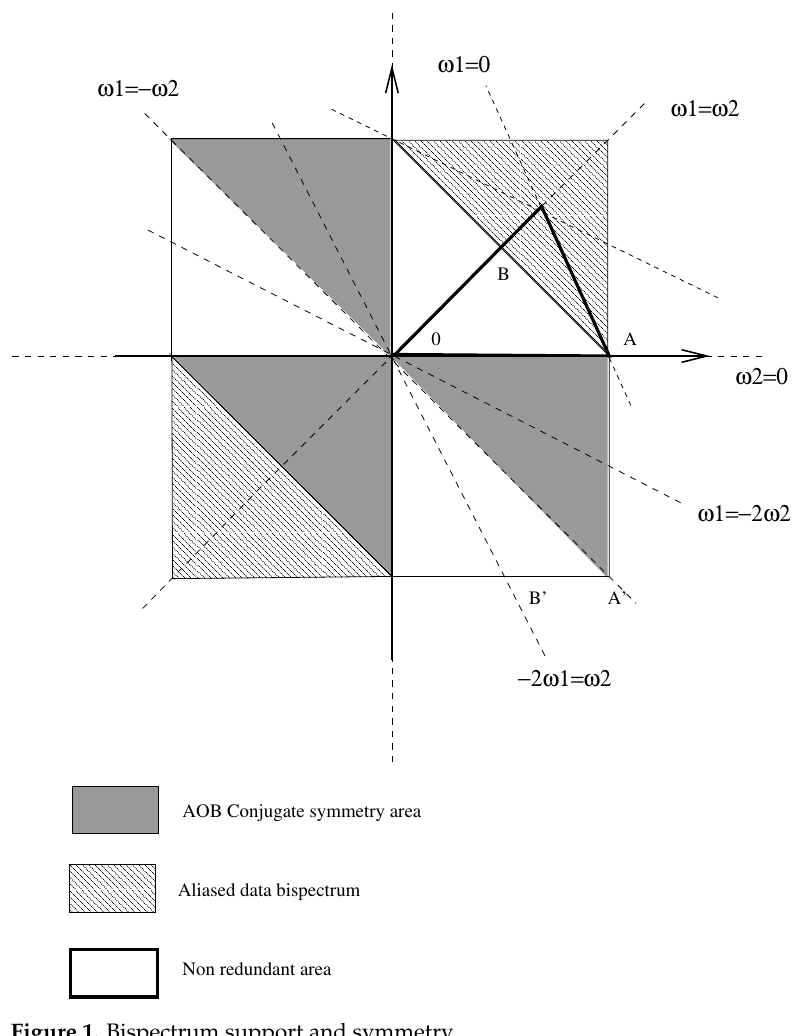
Figure 1. Bispectrum support and